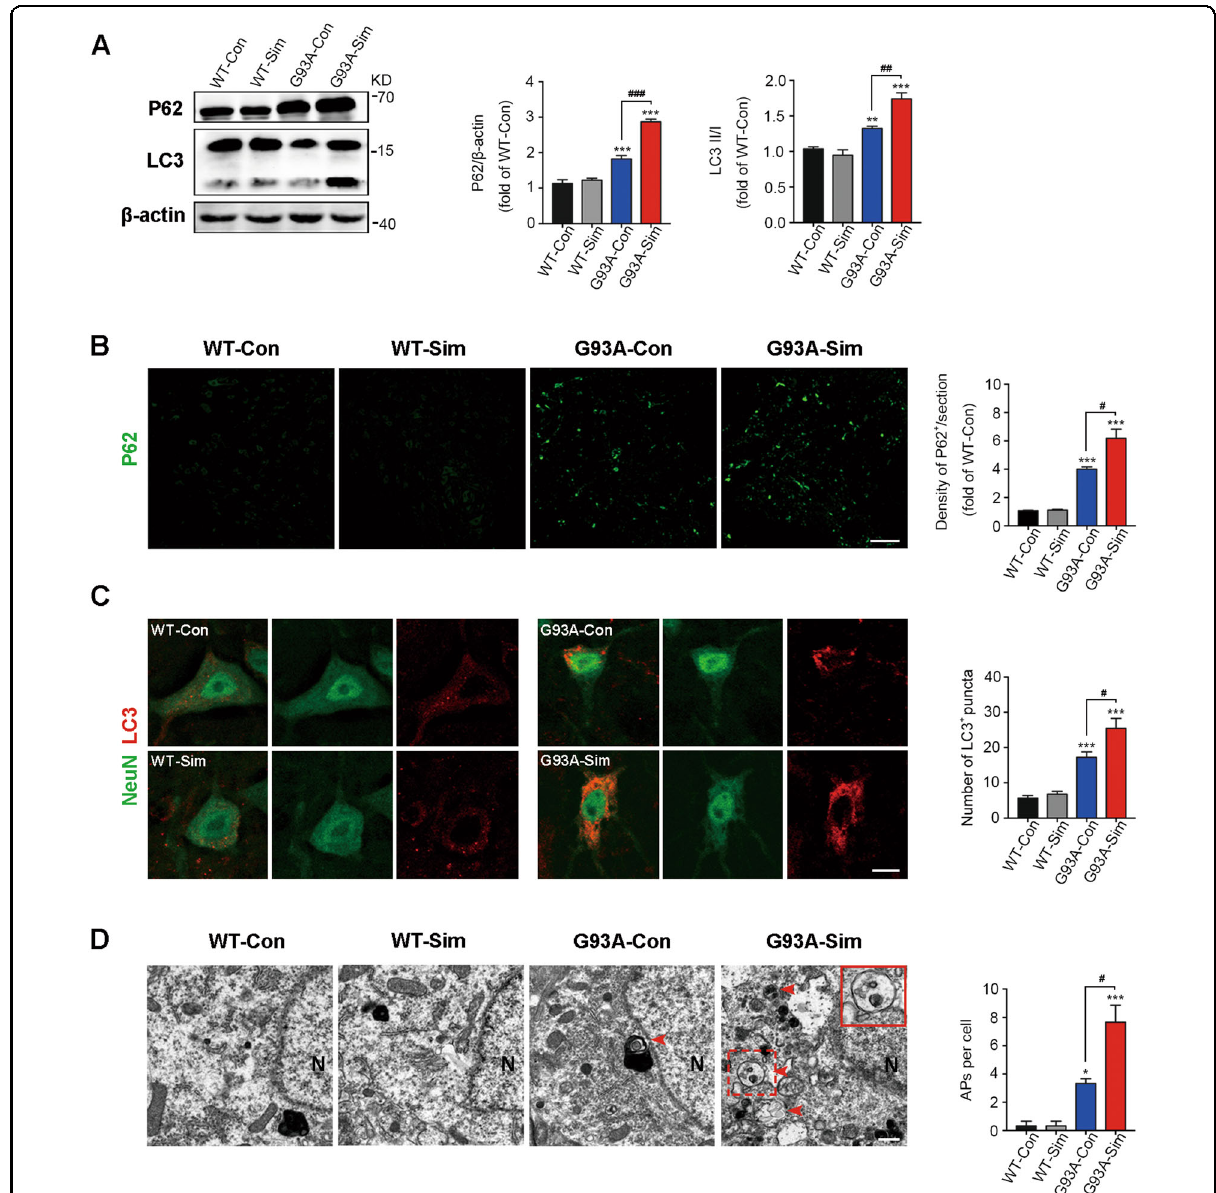
Fig. 1 Simvastatin aggravated impairment of autophagic fl ux in SOD1 G93A mice. A Western blot analysis of P62 and LC3 in the lumbar spinal cords of WT and SOD1 G93A mice treated with or without simvastatin at 120 days. Quanti fi cation of P62 and LC3 levels from immunoblots normalized to the WT-Con group. B Immuno fl uorescence labeling of P62 (green) in the lumbar spinal cord at 120 days (Scale bar, 100 μ m). Quanti fi cation of the average density of P62-positive cells per section. C Immuno fl uorescence labeling of LC3 (red) in NeuN-positive motoneurons (green) at 120 days (Scale bars, 10 μ m). Quantitative analysis of LC3 puncta. D TEM micrographs showed that APs are present in the cytoplasm of MNs in SOD1 G93A mice at 120 days and that these structures are absent or rare in MNs of WT mice (red arrowheads; N, nucleus; scale bar, 1 µm). The upper right image shows magni fi cations for the red dotted box, as shown in the red solid line box. The histogram shows the quanti fi cation of APs per cell. (Data represent the mean ± SEM, n = 5 mice per group; statistical signi fi cance was assessed by one-way ANOVA or an unpaired t -test, * P ≤ 0.05, ** P ≤ 0.01, *** P ≤ 0.001, # P ≤ 0.05, ## P ≤ 0.01, ### P ≤